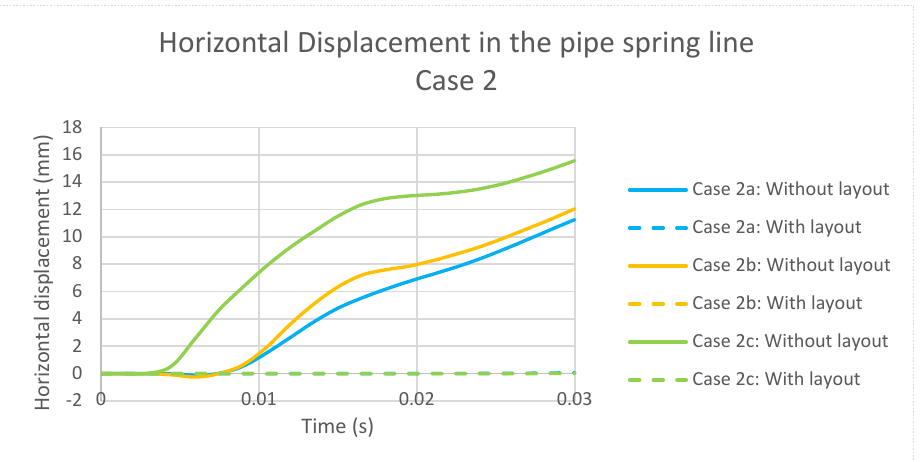
Figure 10. Horizontal displacements in the pipe spring line for case 1.